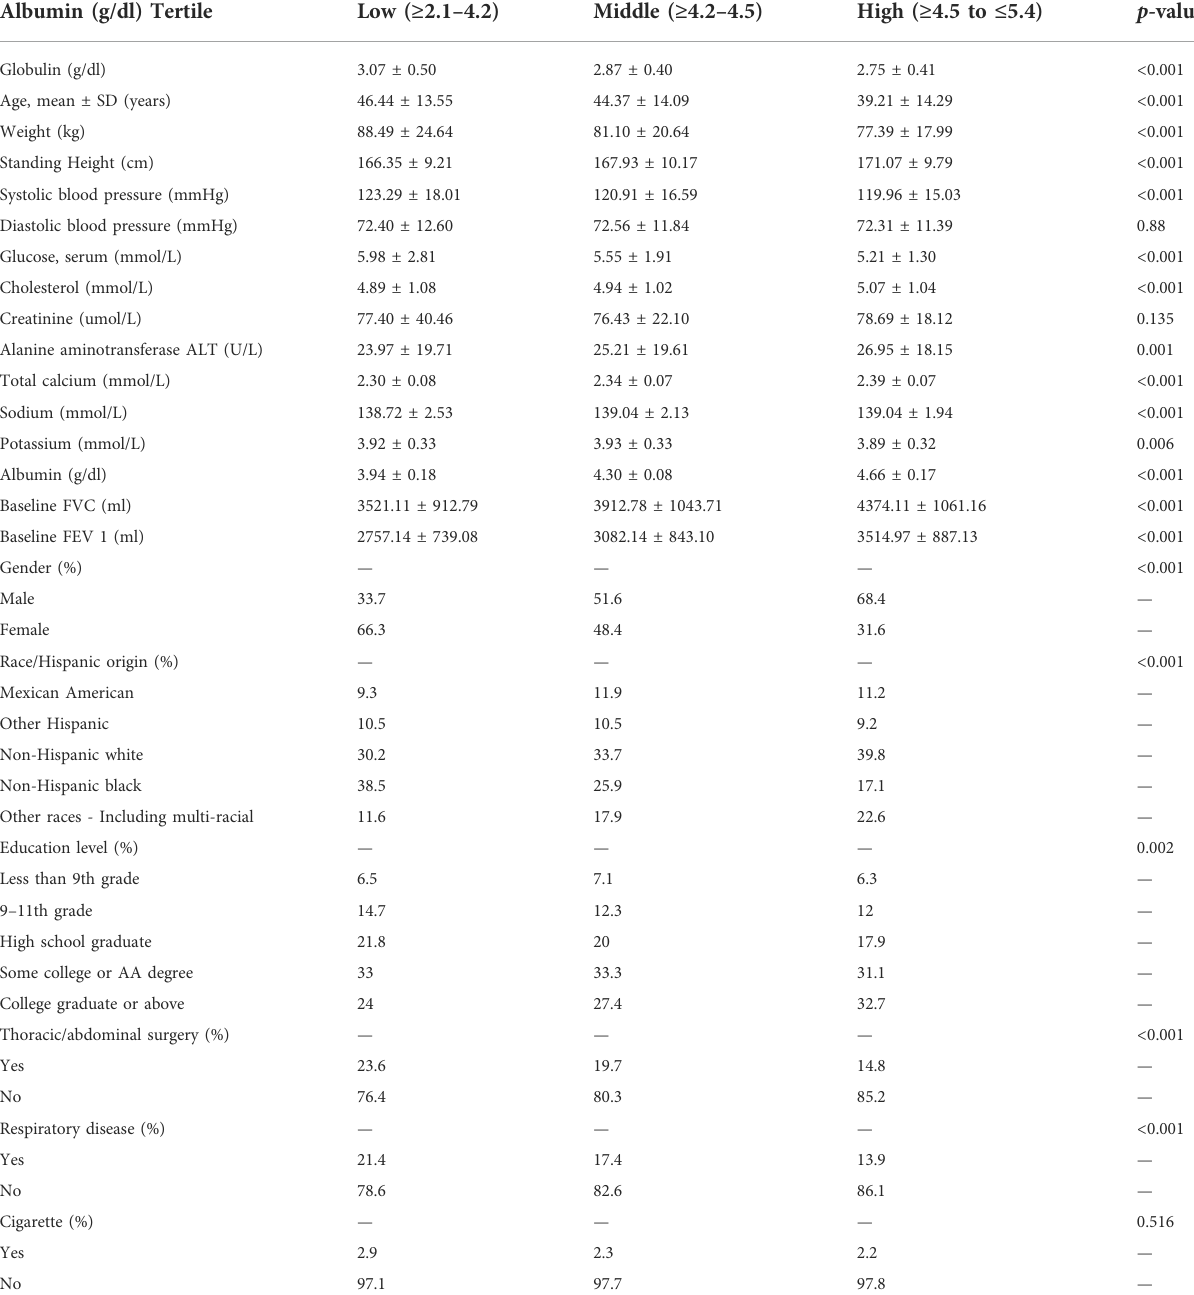
TABLE 1 Baseline characteristics of participants strati fi ed by serum albumin tri-sectional quantiles. Albumin (g/dl)